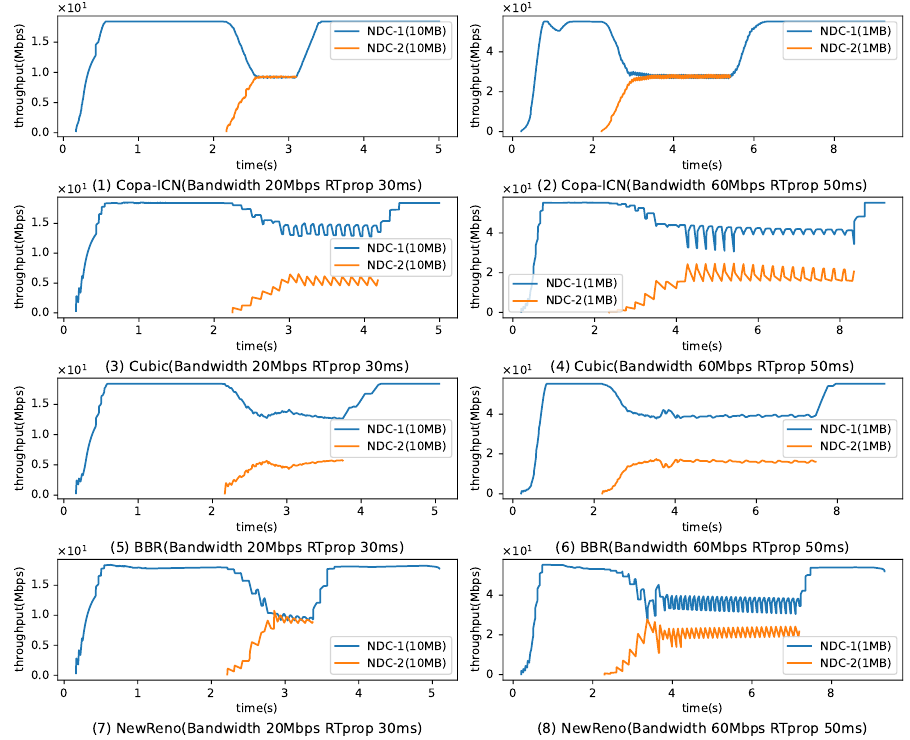
Figure 7. Variation of throughtput with time for different factors (algorithm, bottleneck bandwidth, RTprop, and NDC